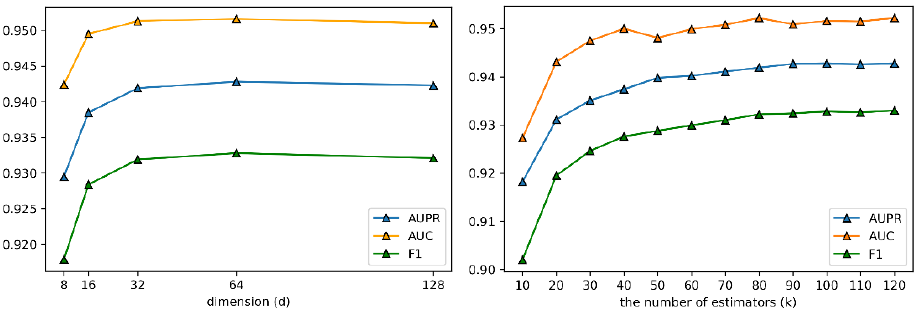
Figure 4. Parameter Sensitivity of our method. ( Left ) The dimension of representation vector 𝑑 , ( Right ) the number of estimators in the Random Forest classifier.